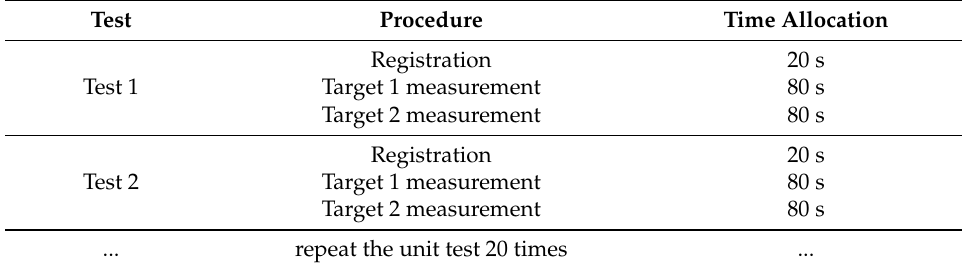
Figure 1. Setup, architecture and workflow of the prototype: The prototype consisted of two parts, namely the mixed reality application running on HoloLens 1 device, and the overhead crane and the lab with its software system; Within the MR application, functionalities were grouped into four modules, namely interaction, visualization, registration and communication; Users wearing the HoloLens 1 device could interact with the crane in a bi-directional manner (i.e., controlling and monitoring) through the MR application under the crane wireless network. Table 1. Protocol for the overall procedure: Unit tests were conducted 20 times, each consisting of initial registration and follow-up measurements on two selected